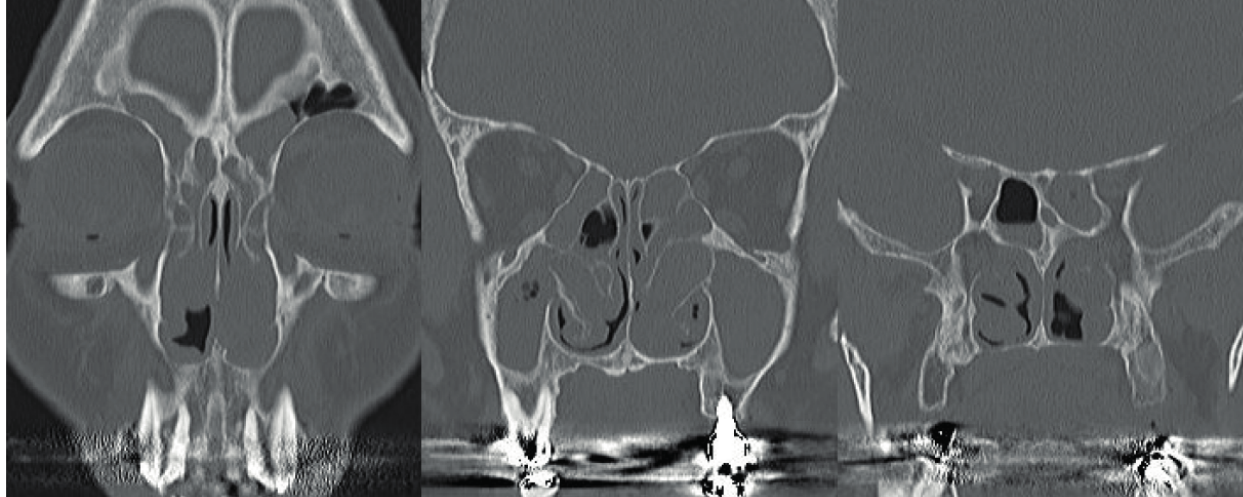
Figure 1. Preoperative sinus computed tomography. Bilateral opacification of frontal, ethmoid, maxillary sinuses, and nasal polyps. Findings of com- puted tomography strongly indicate eosinophilic chronic